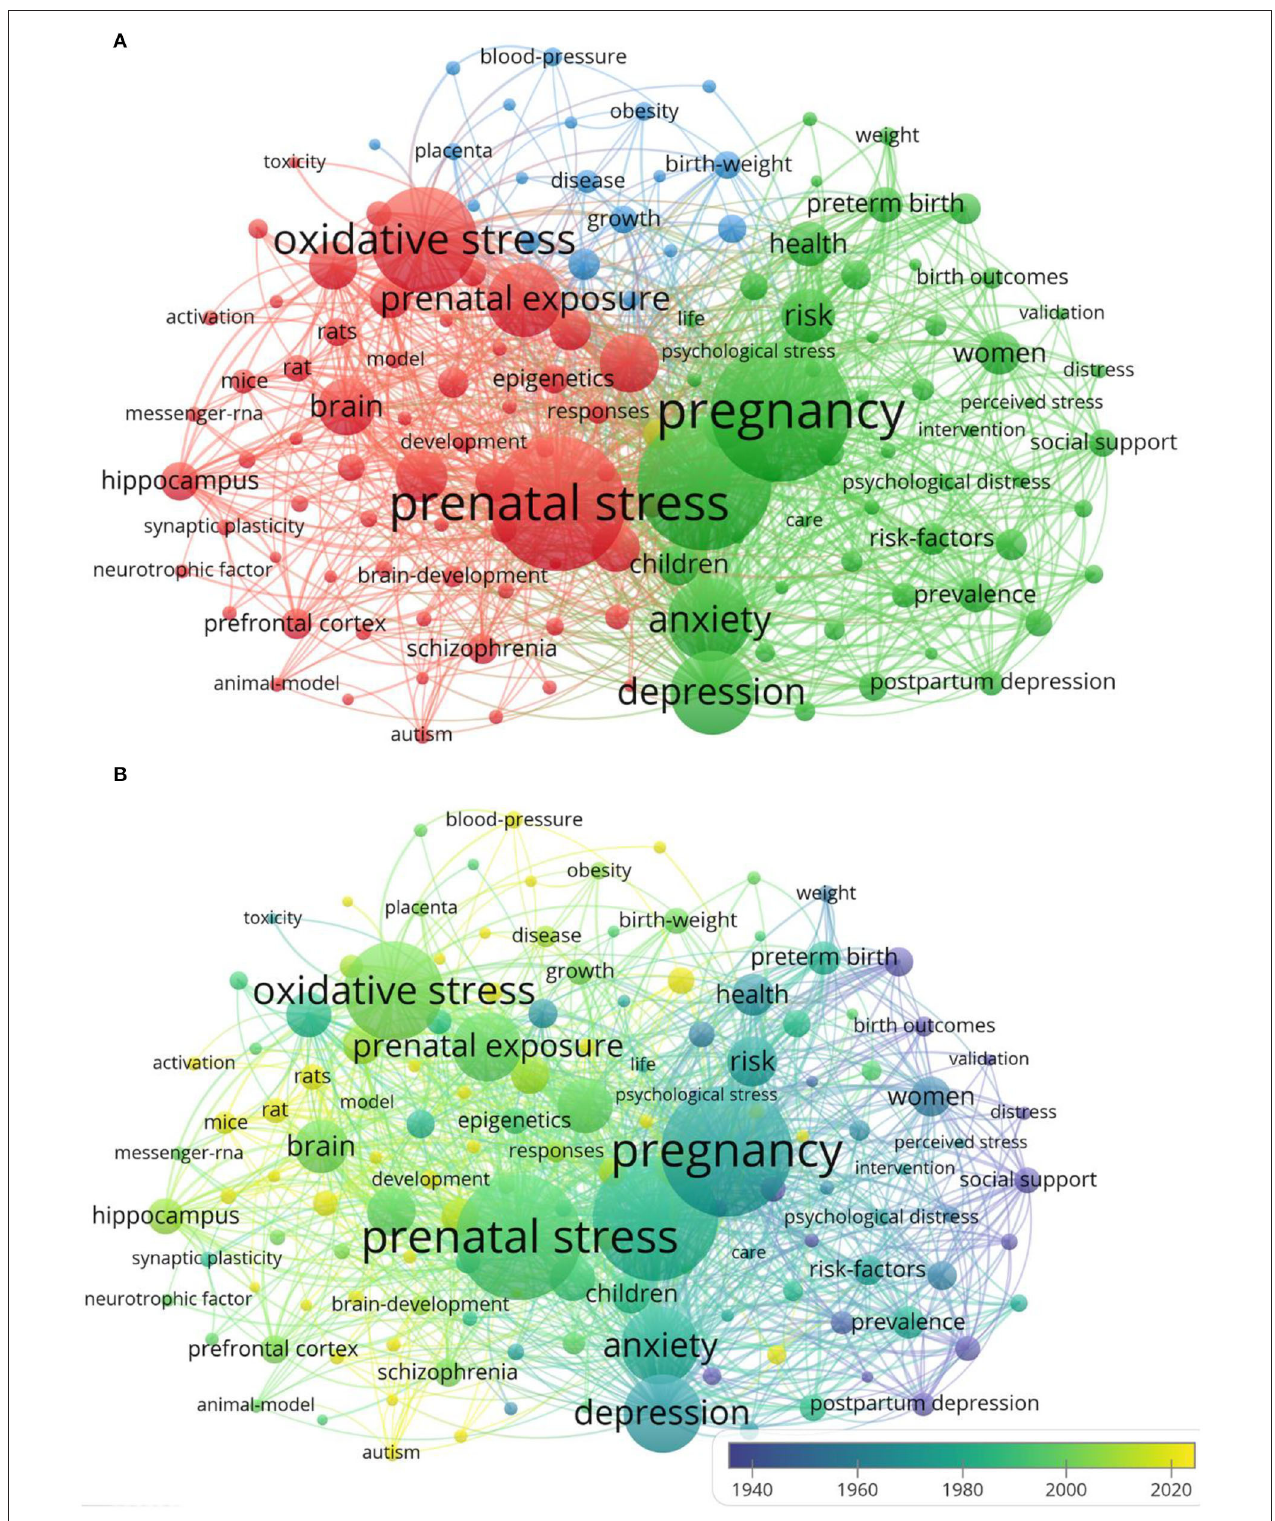
FIGURE 7 | PS keyword network. (A) The 137 keywords that appear more than 80 times are divided into four categories according to different colors: the first category: red, the second category: green, the third category: blue, and the fourth category: yellow. The size of the node indicates the frequency of occurrence. (B) Visualization of the keywords according to APY. The yellow keywords appear later than the blue keywords.